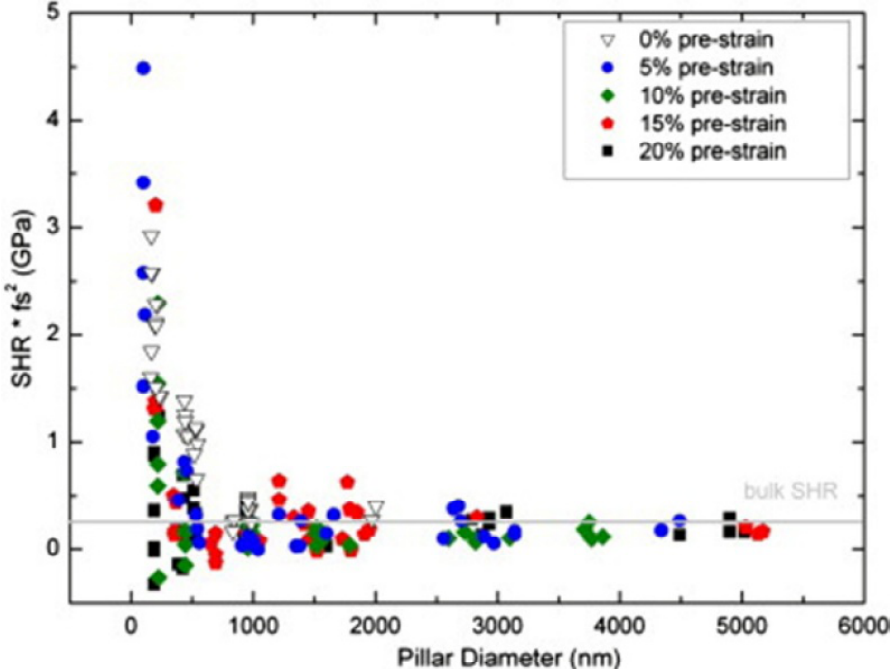
Fig. 23. Strain hardening rate (SHR) versus pillar diameter for pre-strained Ni single crystals. In order to take into account the sample orientations, the SHR was multiplied by Schmid factor square (fs 2 ). Reprinted with permission from Schneider AS, Kiener D, Yakacki CM, Maier HJ, Gruber PA, et al. 2013. Influence of bulk pre-straining on the size effect in nickel compression pillars. Materials Science and Engineering: A 559, [236]: (c) 2013 Elsevier